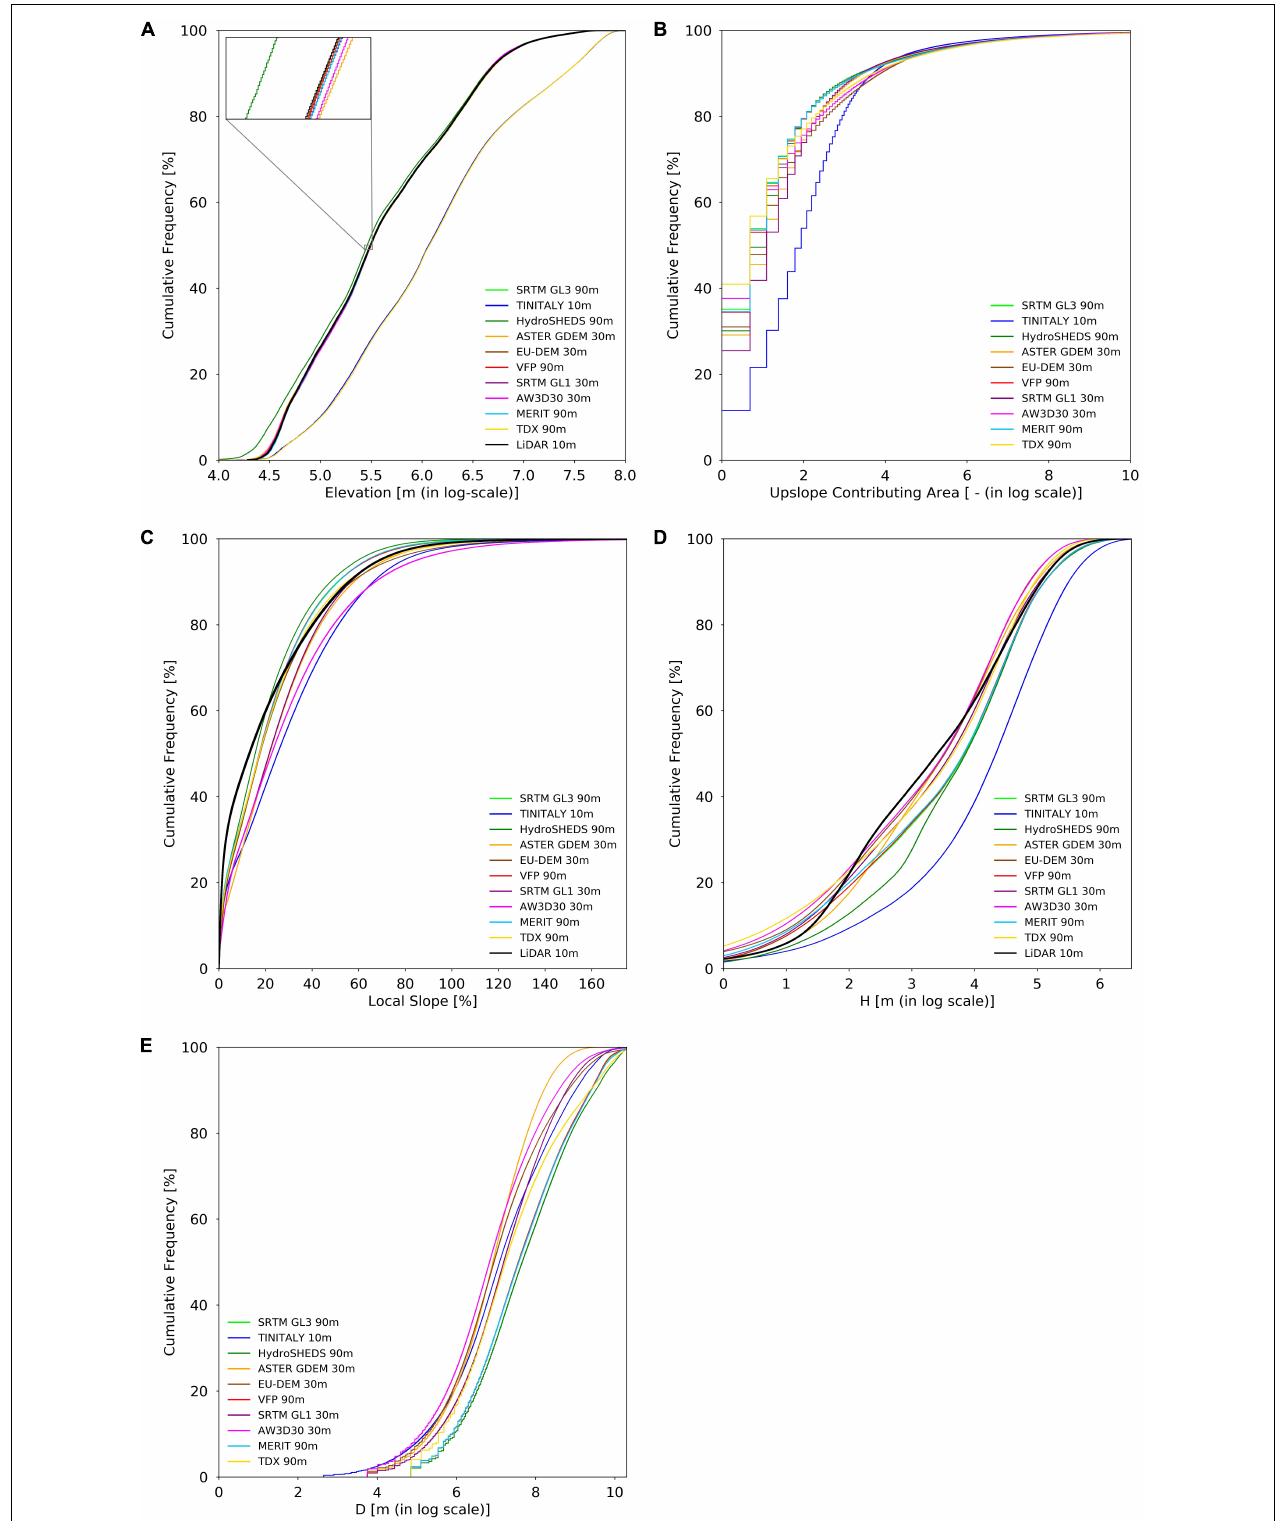
FIGURE 4 | Cumulative frequency curves of terrain descriptors extracted from free digital elevation models (DEM) within the Tanaro river basin, in Italy. (A) Terrain elevations within the light detection and ranging (LiDAR) footprint; (B) upslope contributing area; (C) local slope within the LiDAR footprint; (D) elevation difference to the nearest stream, H, within the LiDAR footprint; and (E) distance to the nearest stream, D. Logarithmic scales refer to the natural logarithm.